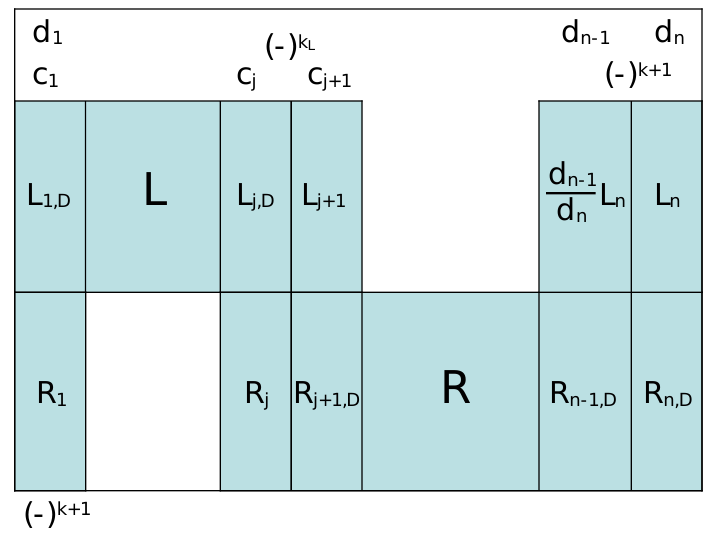
Figure 14 . Matrix version of 1-loop BCFW forward-limit terms.